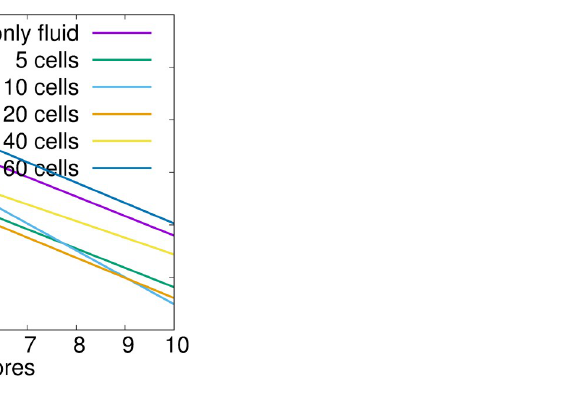
Fig 6. Parallel efficiency of the